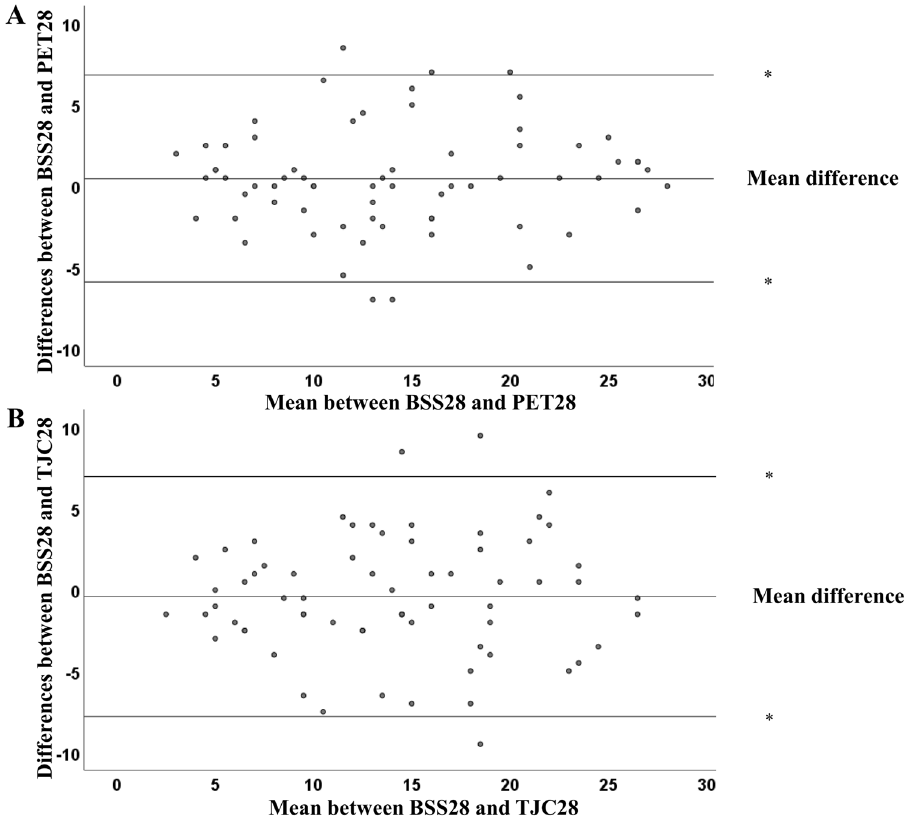
Figure 3. Bland–Altman plot showing the interobserver reliability of assessment of the number of bone scintigraphy-positive joints in 28 joints (BSS28) in relation to PET positive joint count in 28-joints (PET28) ( A ) and the tender joint count in 28-joints (TJC28) ( B ). Mean between BSS28 and PET28 = average of the joint count as determined by the BSS28 and the joint count as determined by the TJC28. The mean differences between the BSS28 and PET28, and the BSS28 and TJC 28 were 0.46 and − 0.40, respectively, and the majority of plots (62 of 67 [92.5%] and 64 of 67 [95.5], respectively) were within the upper and lower limits of 2 SD (lines with asterisks).